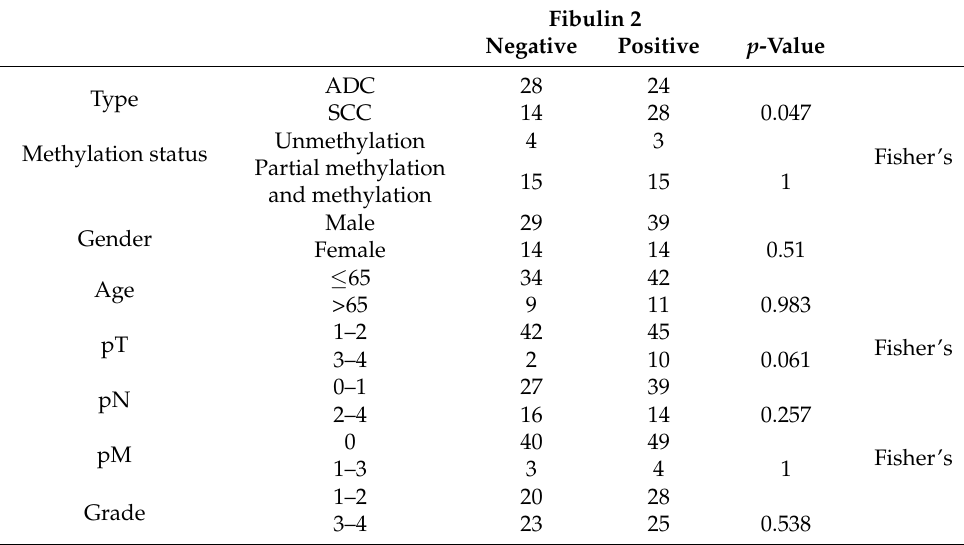
Table 1. Association between fibulin 2 protein expression and clinicopathological parameters in primary lung